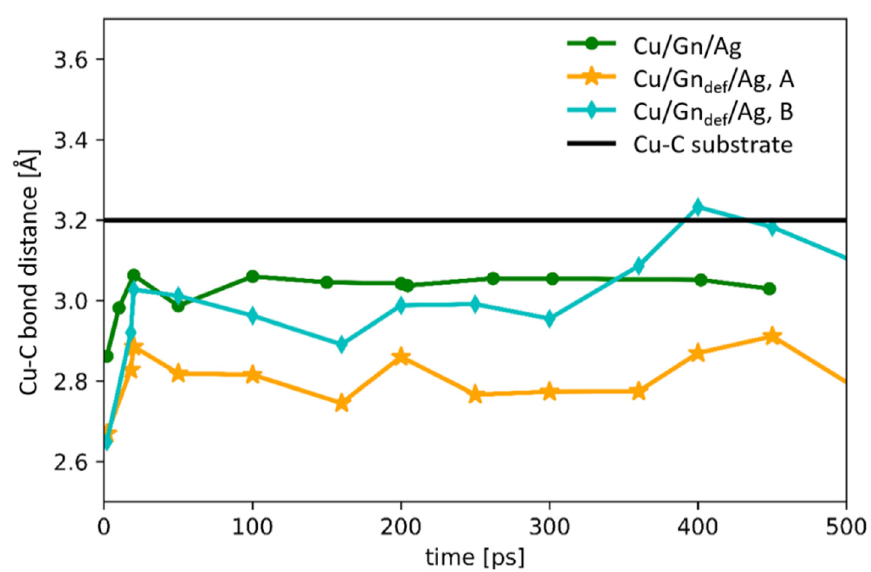
Figure 4. Time evolution of Cu-C bond length Cu/Gn/Ag and Cu/Gn def /Ag systems. Green line represents the results for Cu/Gn/Ag system, while part A and part B of Cu/Gn def /Ag are illustrated by orange and light blue lines, respectively. Black line was added for a comparison and denotes a reference Cu-C bond distance of Cu/graphene interface.